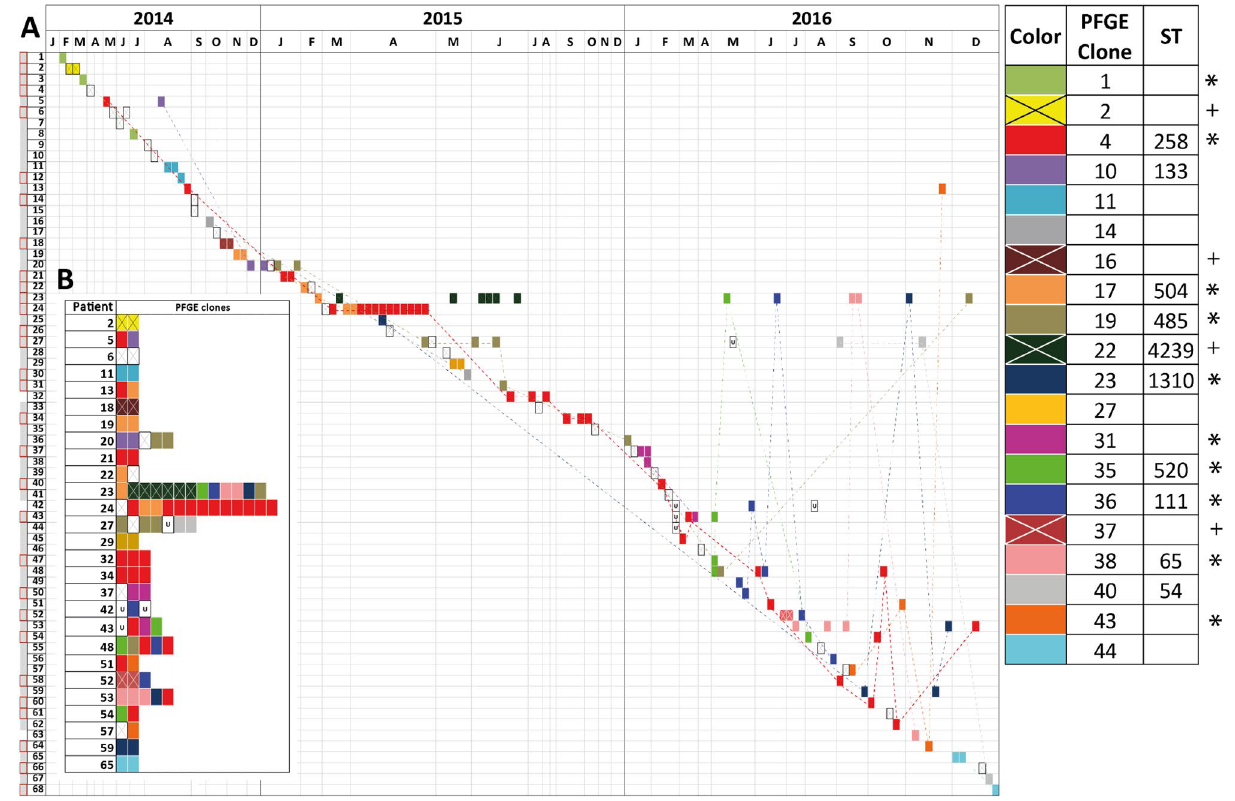
Figure 1. Circulation dynamics of the clones of Klebsiella pneumoniae carrying bla KPC gene in one complex health institution during 3 years. ( A ) On the left side are the patients and above the months of the respective years. The gray boxes next to the number of each patient indicate the prior antibiotic treatment to first KPC- Kp event, and were highlighted with a red border, those who had carbapenems among the therapeutic options used. The white rectangles with a X indicate the 25 clones that were identified in a single event, and colored rectangles indicate the 20 clones that were identified in two or more events (see upper right box for more information). The boxes marked with a "U" indicate those isolates in which it was not possible to identify the pulsotype and therefore the associated clone is unknown. The legend specifies the clones that were detected in a single patient (+) or in more than three patients (*), and the dotted lines indicate the order of appearance of the clones isolates from two or more patients. ( B ) It only illustrates in colored boxes KPC- Kp isolates of patients who had more than one event, which allows us to observe intra-patient clonal